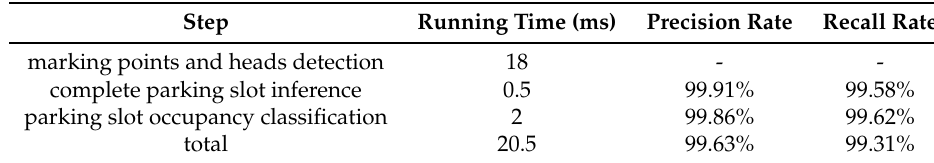
Table 8. Overall performance of VPS-Net in the ps2.0 test set.